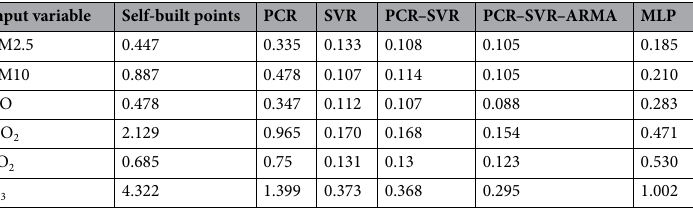
Table 6. MAPE of six types of air pollutant concentrations between self-built points, model forecast values and national control point.